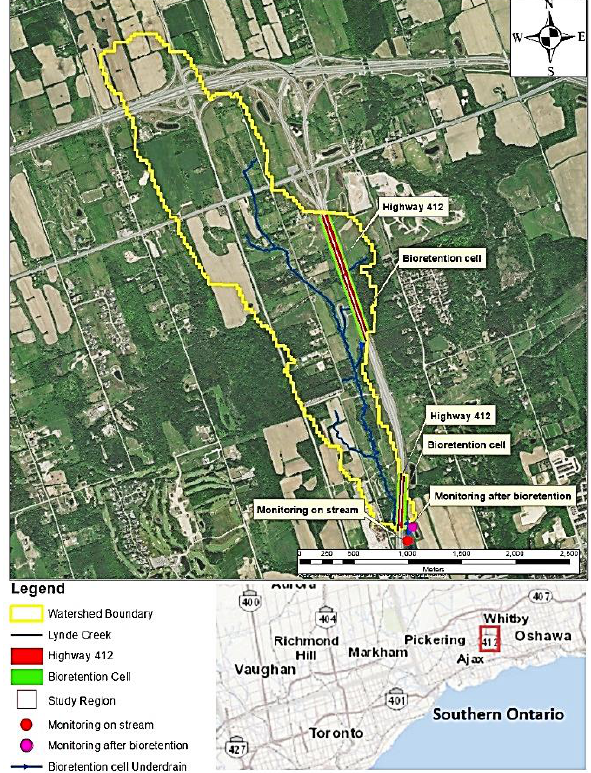
Figure 5. ERDS locations within the Lynde Creek watershed.